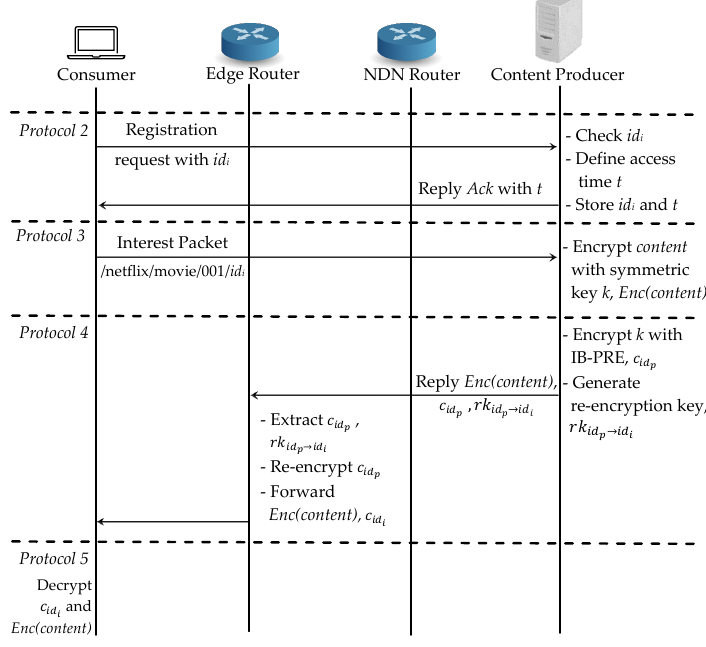
Figure 5. Proposed scheme: Case (1) a consumer requests a fresh